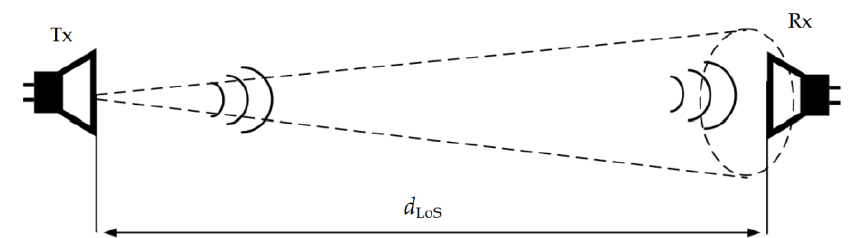
Figure 2. LOS propagation in free space.